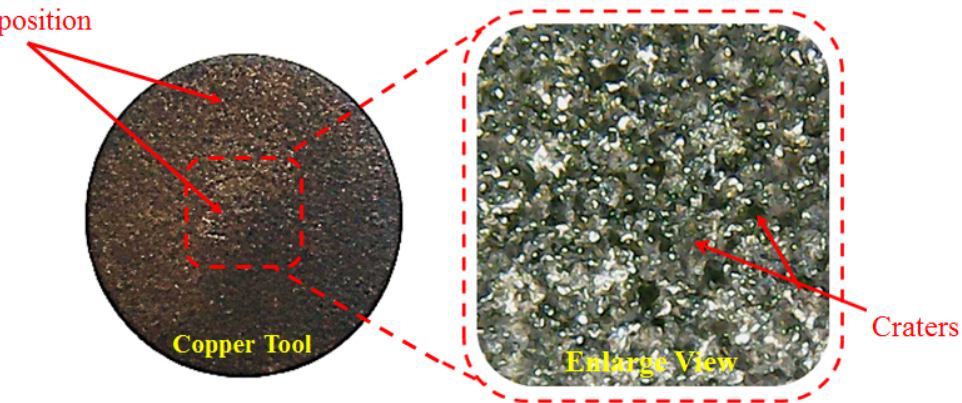
Figure 16. Micro-surface of copper tool showing carbon deposited on the surface.